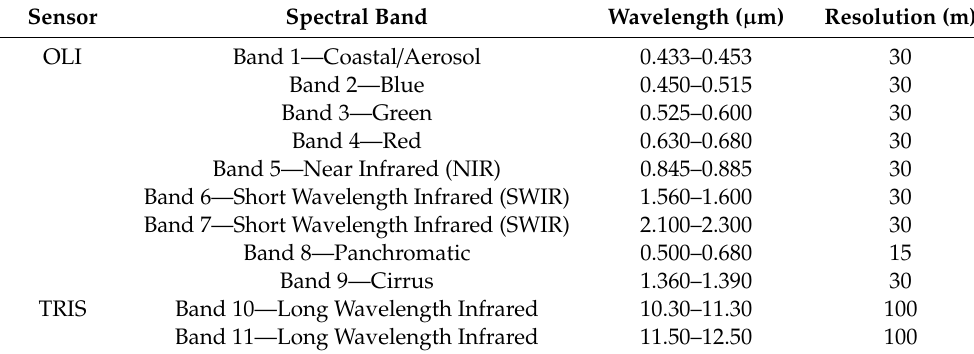
Table 1. Landsat-8 specifications for bands. Bands 1 to 9 are operational land imager (OLI) spectral bands and bands 10 and 11 are thermal infrared sensor (TIRS) spectral bands.